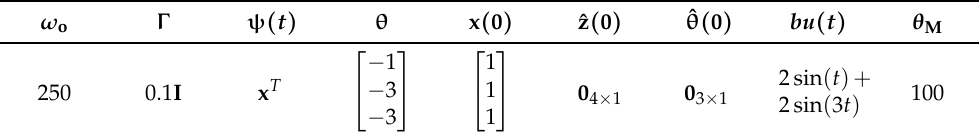
Table 3. Parameters of the simulation of PIESO with state dependent